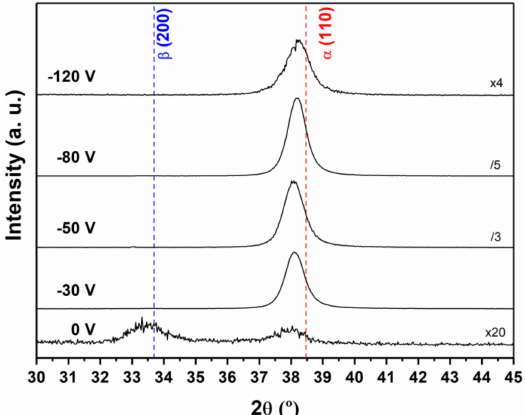
Figure 3. X-ray di ff raction patterns of the Ta films prepared by DOMS with the increase of substrate bias. On the right of the figure is inserted the signal